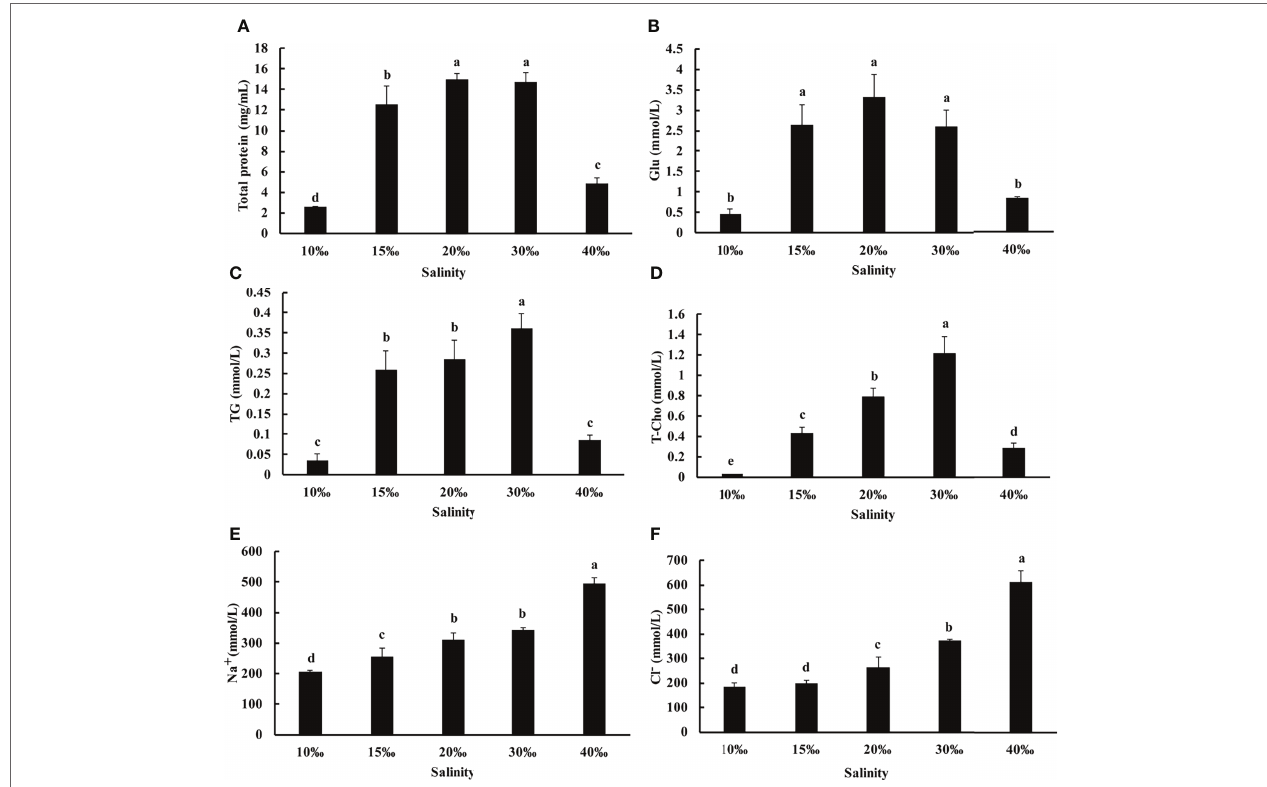
FIGURE 1 | The contents of total protein (A) , glucose (Glu, B ), triglycerides (TG, C ), total cholesterol (T-Cho, D ), Na + (E) and Cl - (F) in the coelomic fluid samples of U. unicinctus juvenile reared in different salinities for 8 weeks. The data are mean values of three replicates + SD (n = 3). Different letters indicate significant differences at different salinity (ANOVA, Tukey’s test; P <